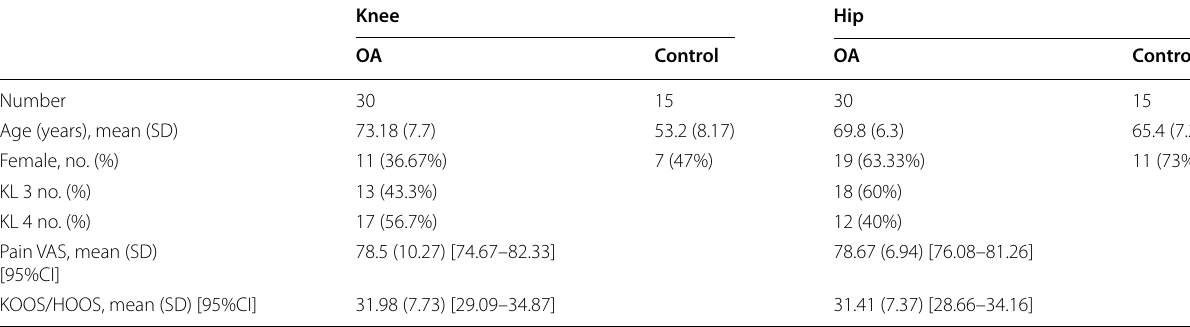
OA osteoarthritis, VAS = Osteoarthritis Outcome Score, SD